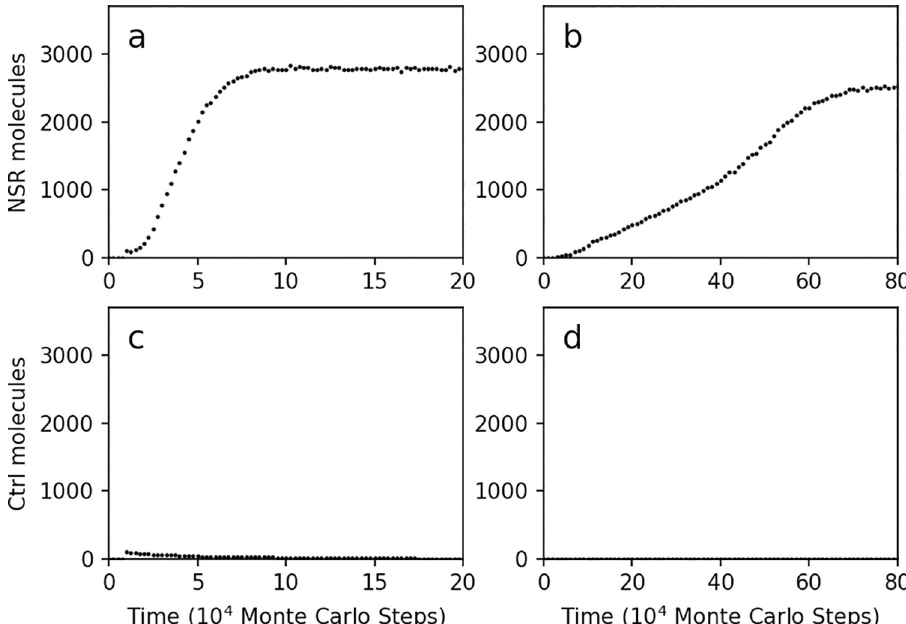
Fig 6. Using the difference between the NSR and control molecules as the objective function resulted in the parameter set favoring the spread of NSR but not the control. In reference of the case shown in Fig 5A, the parameter set at the 50th round of the machine-learning is adopted: PNF = 8.36 × 10 − 7 , PNFR = 0.036, PND = 3.77 × 10 − 3 , PRL = 9.89 × 10 − 8 , PBB = 3.05 × 10 − 5 , PAT = 0.373, PFP = 2.17 × 10 − 5 , PMV = 2.89 × 10 − 4 . At step 1 × 10 4 , ( a ) one hundred NSR molecules are inoculated; ( b ) one NSR molecule is inoculated; ( c ) one hundred control (Ctrl) molecules, which have no enzymatic activity, are inoculated; ( d ) one control molecule is inoculated (the number symbols lie very close to the horizontal